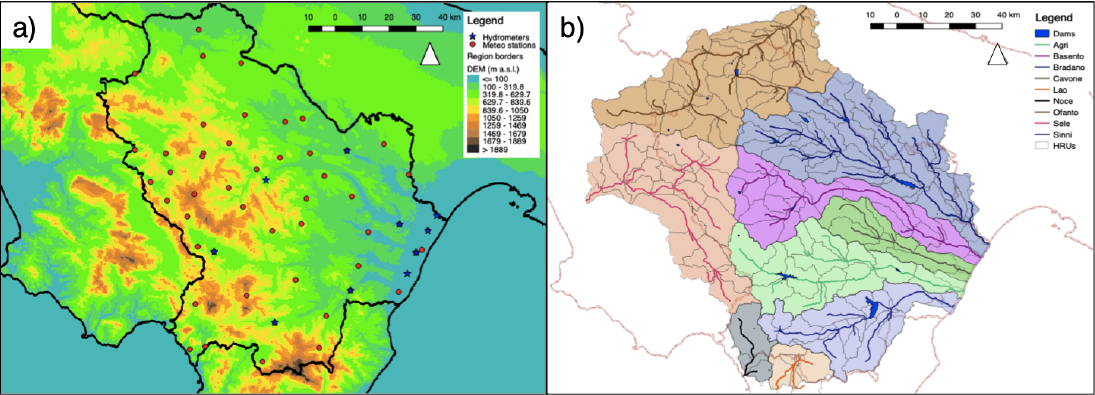
Figure 1. ( a ) Hydrometers (blue stars) and weather stations (red circles); ( b ) basin partitions in HRUs. Each of the nine major rivers is highlighted with a different